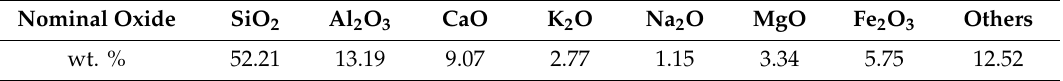
Table 2. Major chemical composition of the loess that was used in the experiment.